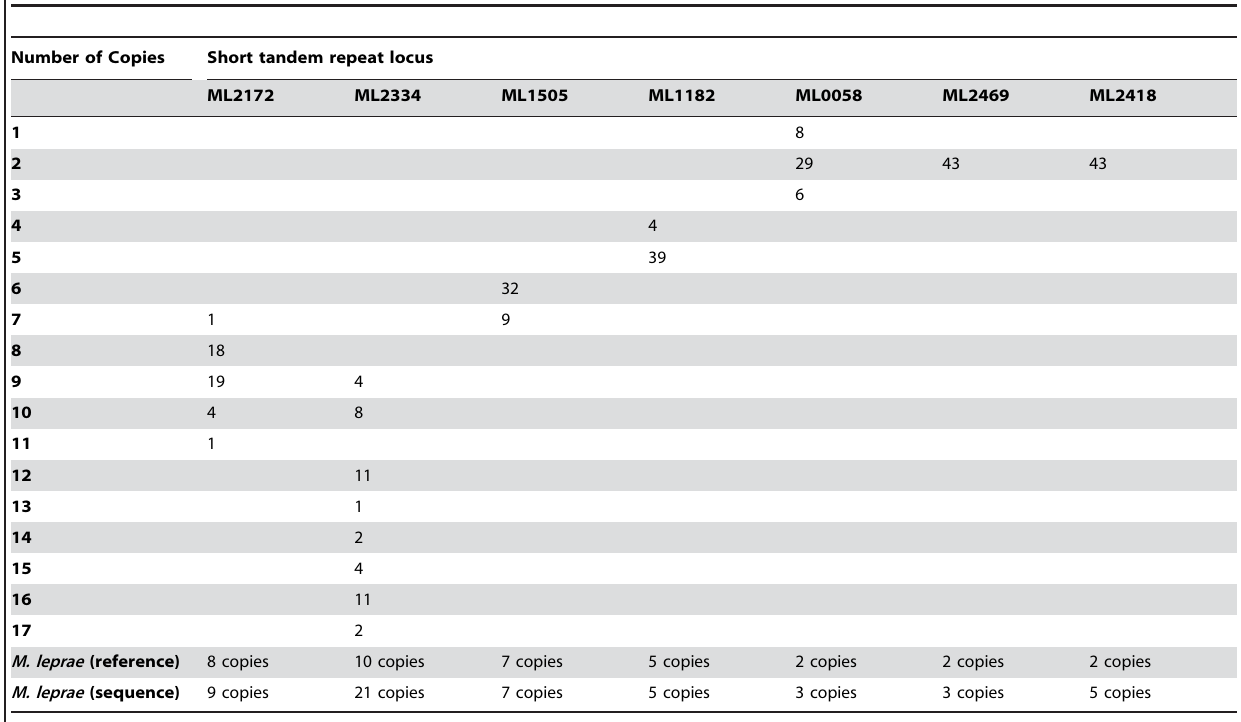
Table 2. Distribution of copy numbers of seven different short tandem repeat loci in the 43 Malawi